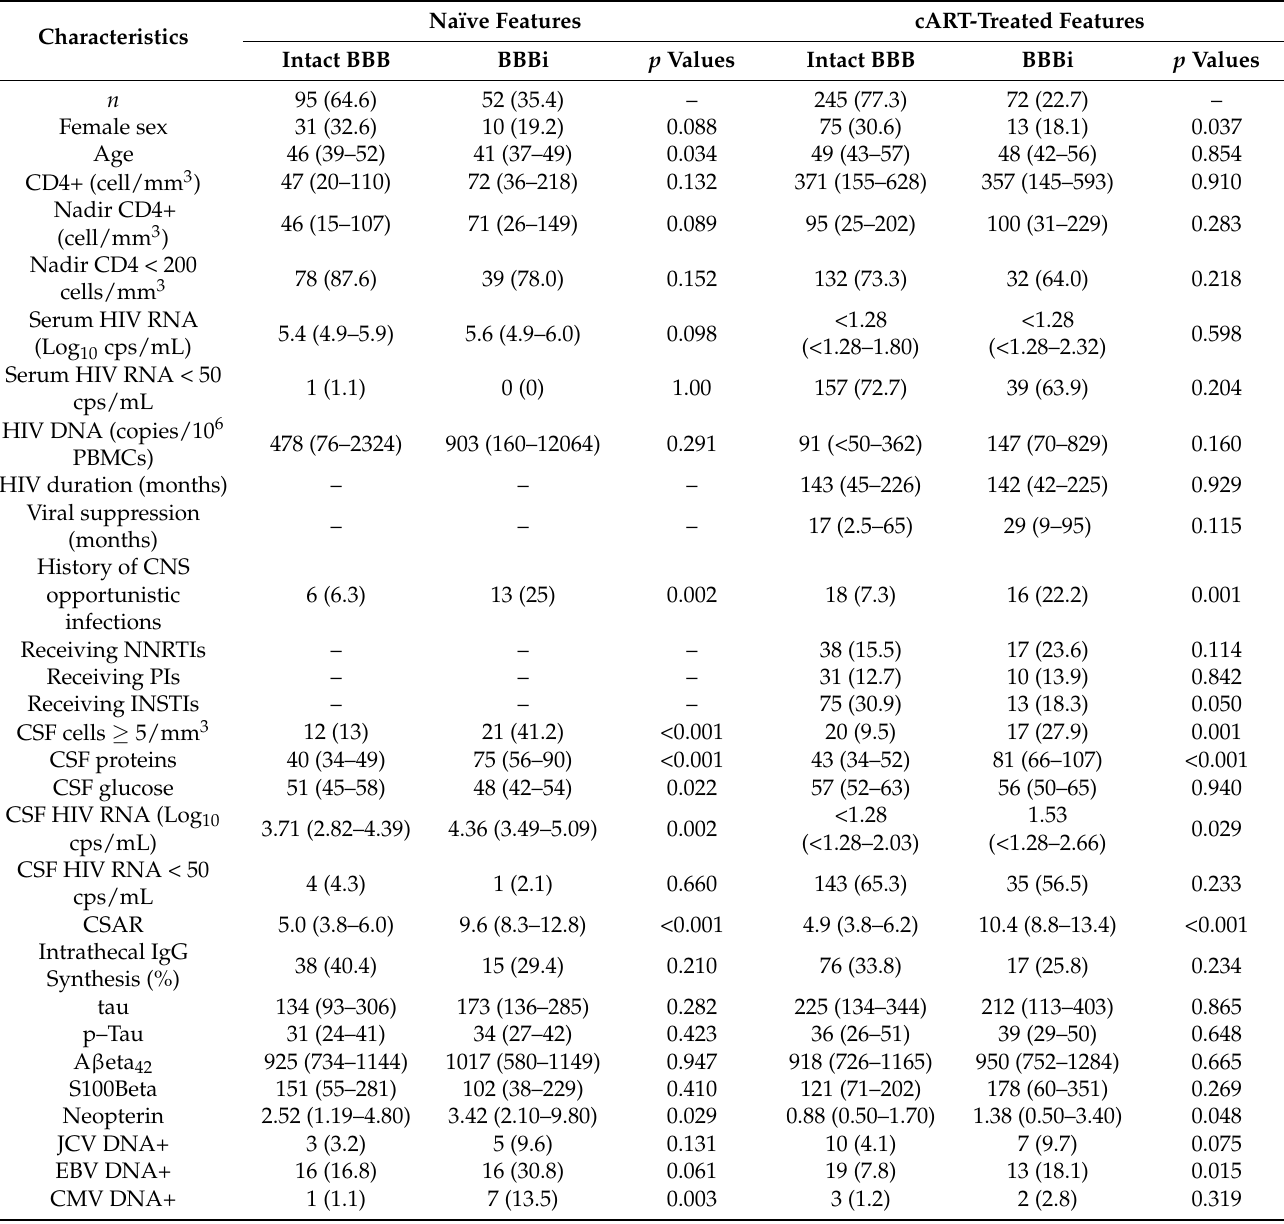
Table 4. Demographic and clinical features, plasma, and cerebrospinal fluid biomarkers in patients with normal and impaired blood–brain barrier. P values are calculated separately in naïve (first column) and treated (second column)